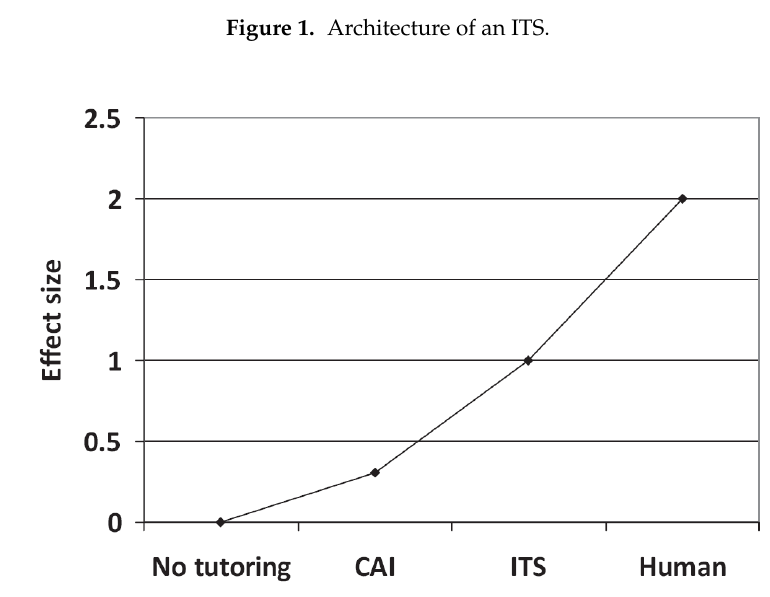
Figure 2. Graphical representation of commonly believed effect/impact vs tutoring